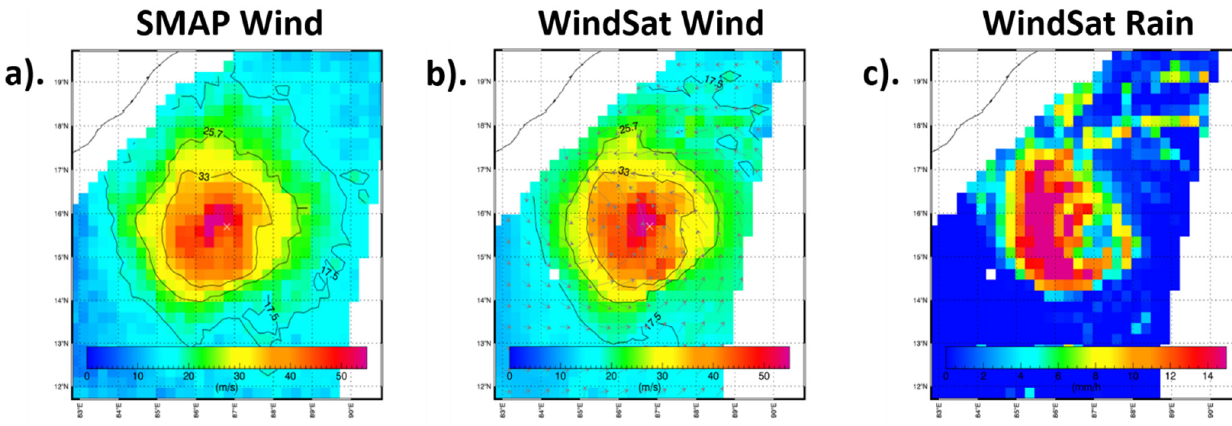
Figure 1. Scalar TC-wind fields for SMAP ( a ) and vector wind fields for WindSat ( b ) along with rain rate as seen by WindSat ( c ) for satellite passes over TC Amphan on 19 May 2020.